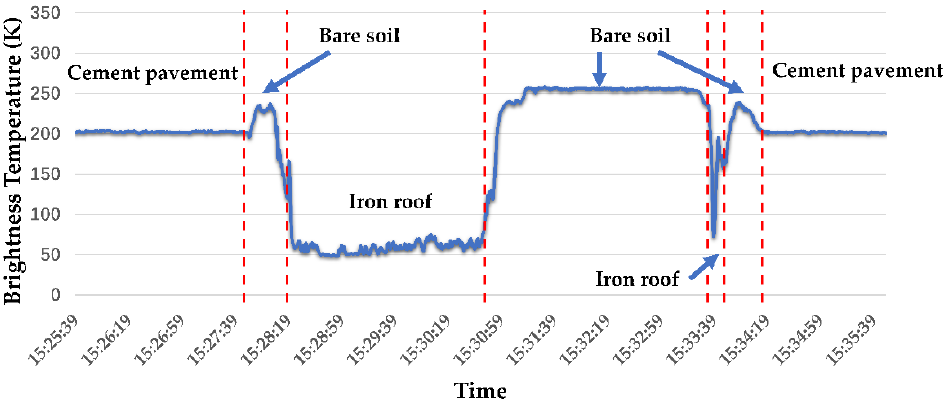
Figure 13. Flight TB measurements of different ground objects.